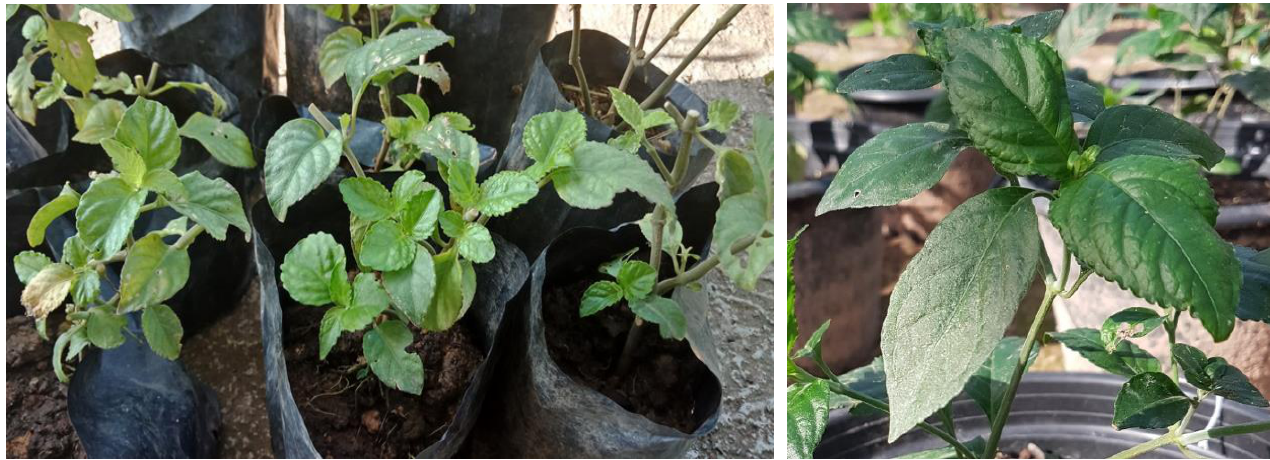
Figure 1. Saplings of Niamhom ( Strobilanthes nivea Craib).